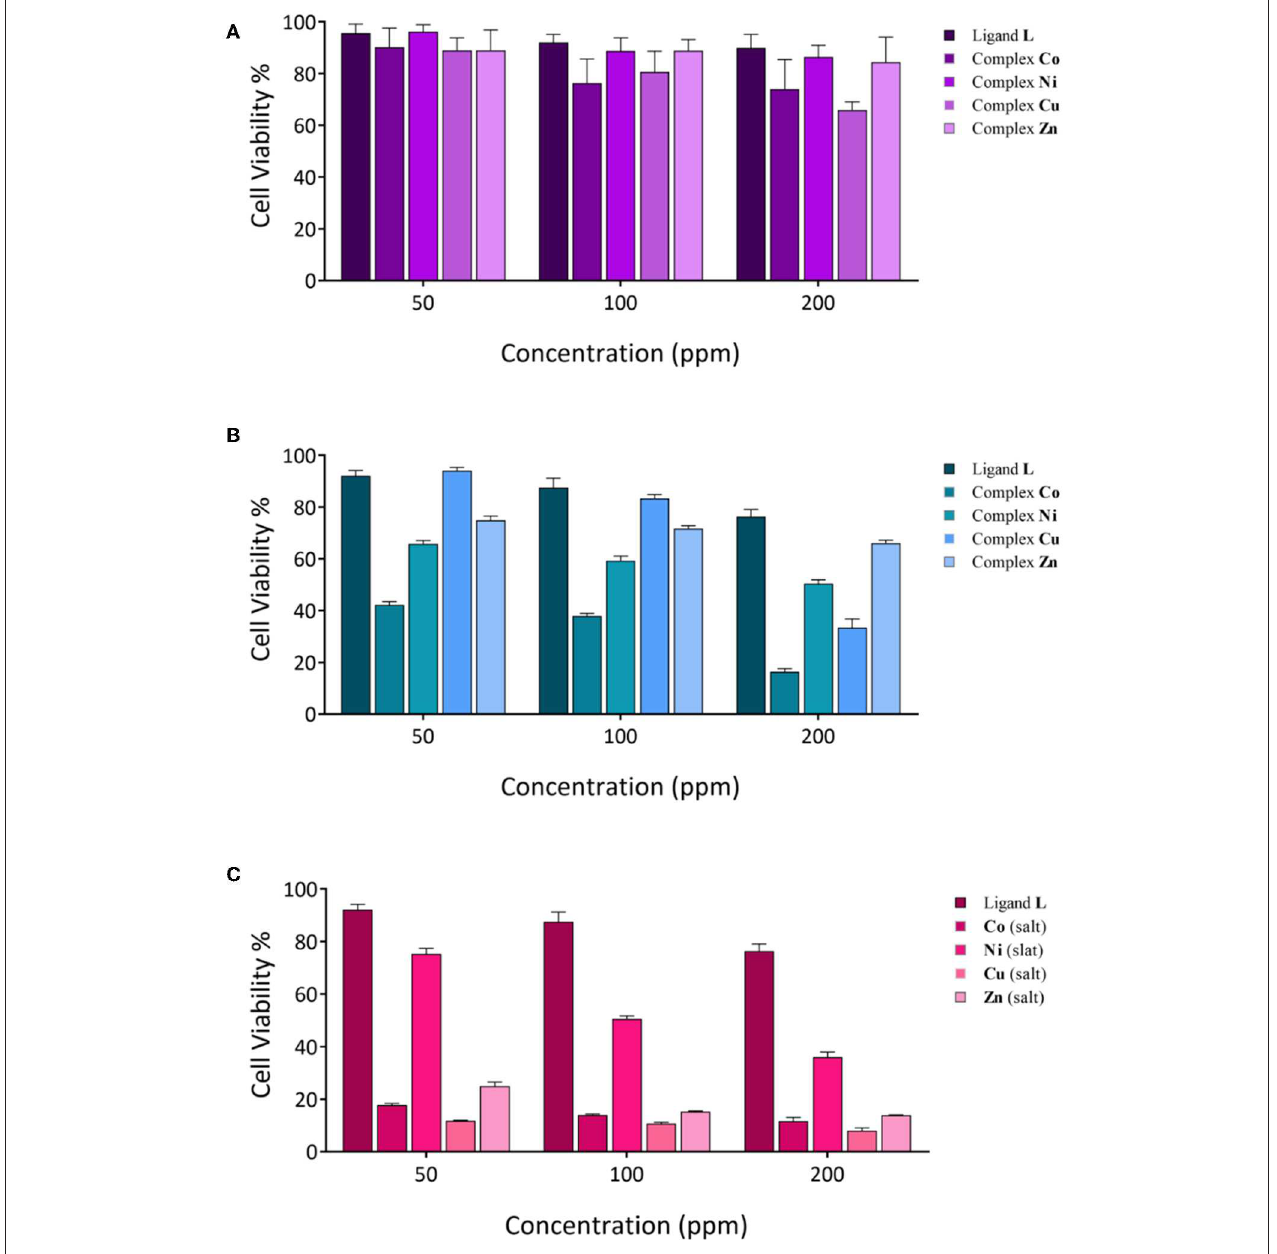
FIGURE 7 | Cytotoxicity evaluation of synthesized compounds at various concentrations against cancer cell lines; (A) MCF-7 cell lines; (B,C) , Saos-2 cell lines.